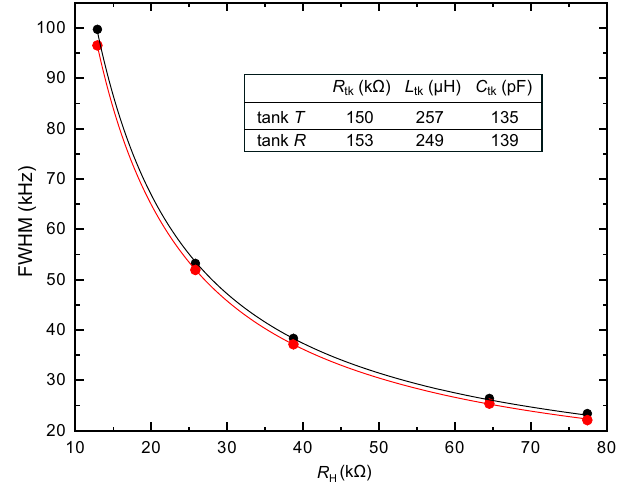
Fig.6|Tankcircuitscharacterization. FullWidthatHalfMaximum(FWHM)ofthe measured tank resonance in the noise signal, as a function of the sample ’ s resis- tance R H . Black (red) dots represent the FWHM of tank T ( R ) measured with the device set on resistance plateaus of known R H ( ν ∈ {2,1,2/3,2/5,1/3}). Solid lines show 1/2 π C tk R , with 1/ R ≡ 1/ R H +1/ R tk . The values of R tk and C tk used as fi t